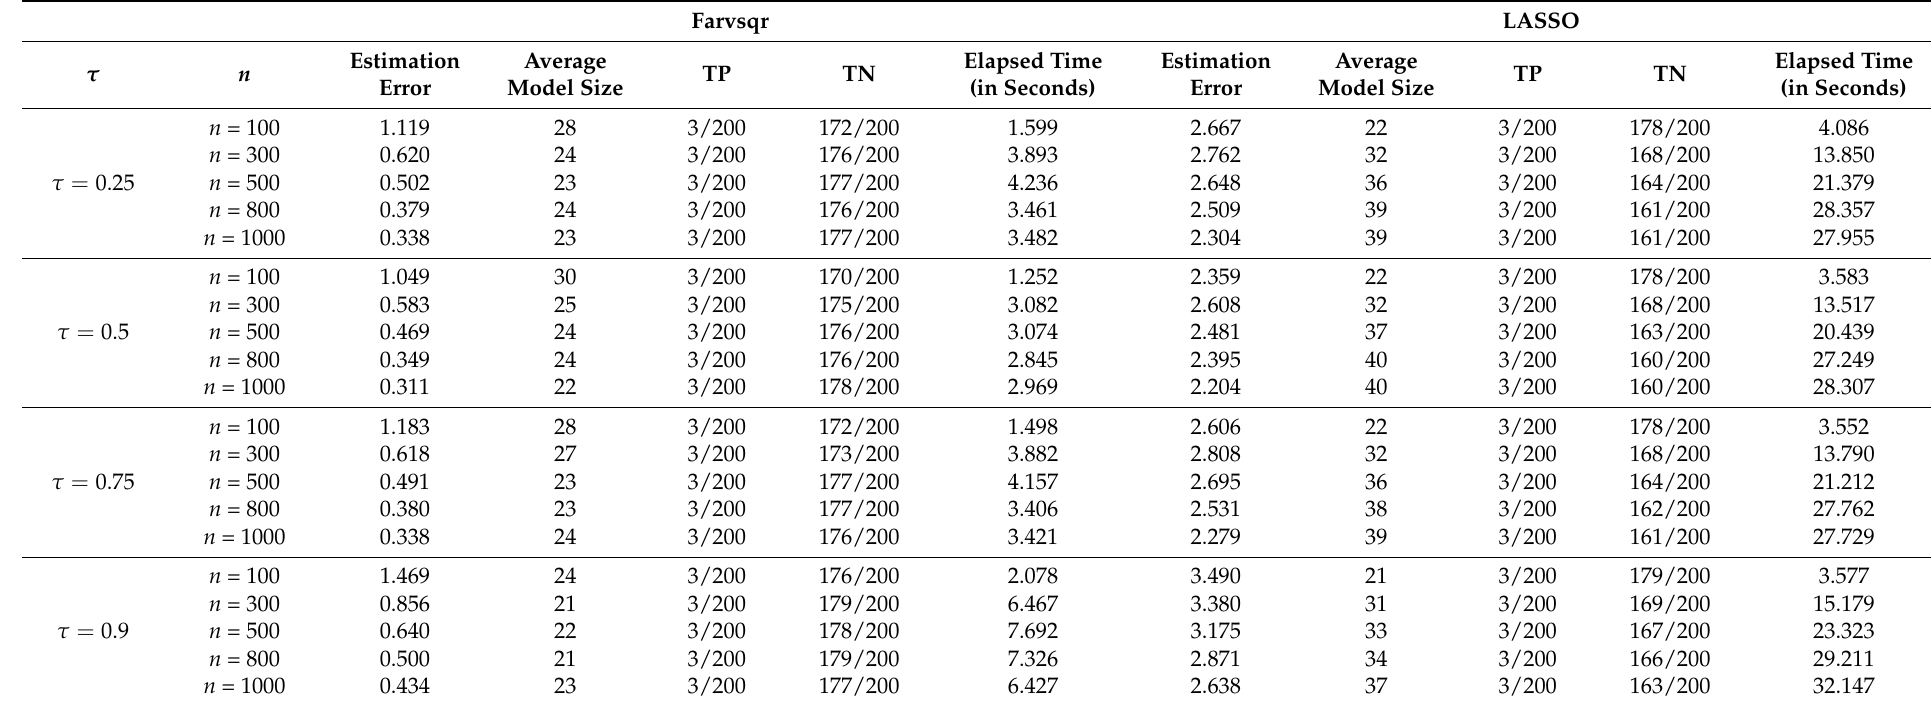
Table 3. The comparison for p = 200,0.1 ∗ N ( 0,1 ) + 0.9 ∗ N ( 0,9 ) with the factor model. Farvsqr